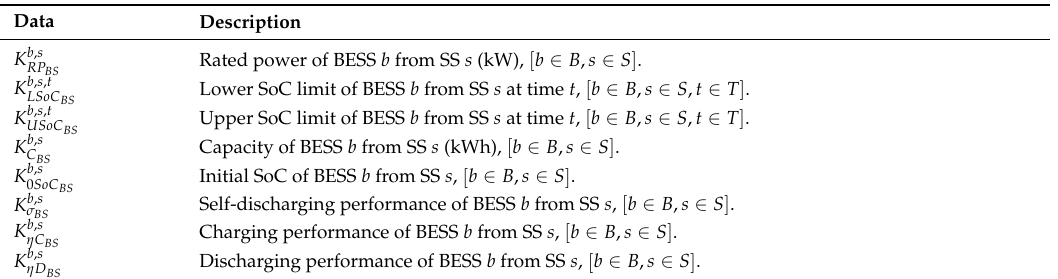
Table 6. Summary of input data (Battery Energy Storage Systems (BESS) parameters).